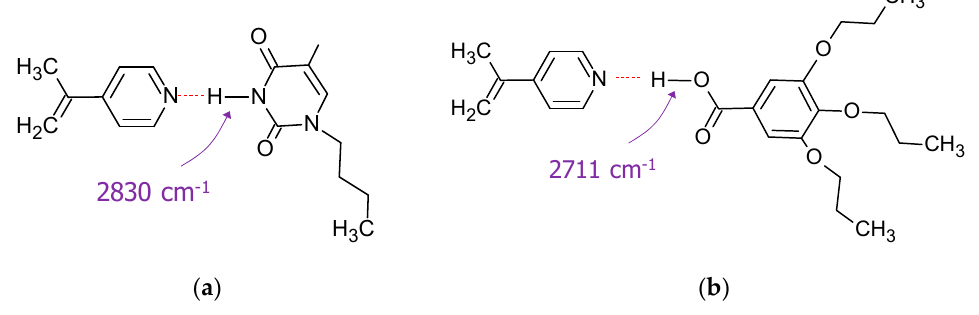
Figure 7. Complexes containing simple pyridine rings as H-acceptors: ( a ) Pyr ● tAZOi-1HB and ( b ) Pyr ● dAZOi-1HB. Vibration frequencies calculated by DFT are also shown. Dotted lines indicate hydrogen bonding.